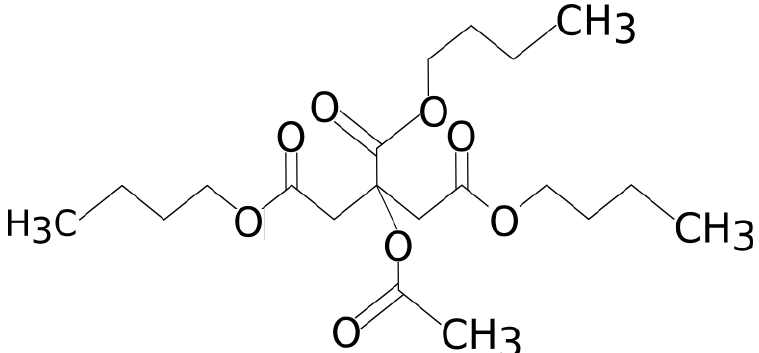
Figure 1. Chemical structure of tributyl acetylcitrate